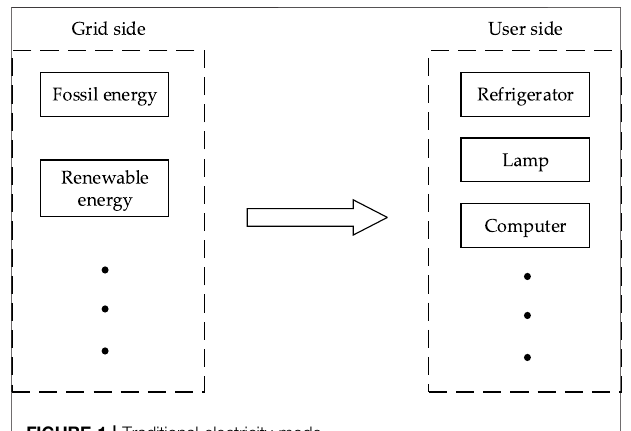
FIGURE 1 | Traditional electricity